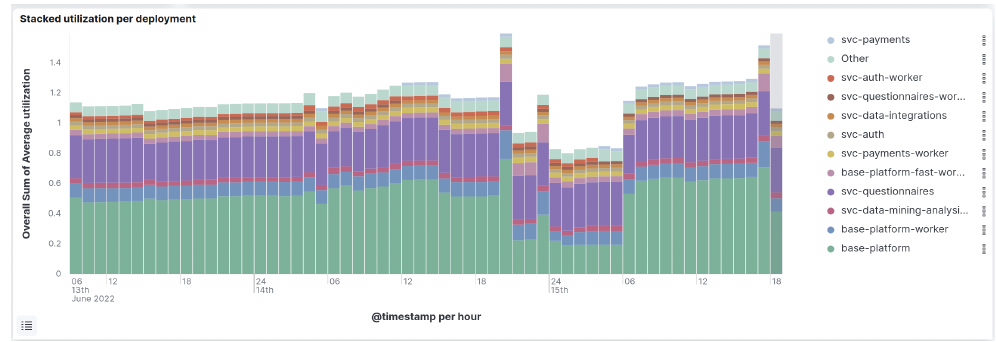
Figure 7. Hourly utilization per microservice deployment in the production environment.